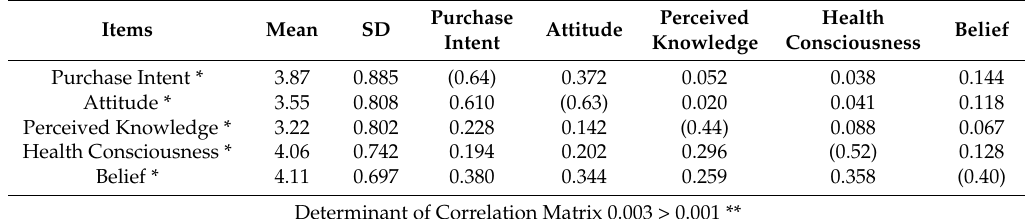
Table 4. Descriptive statistics and correlations among